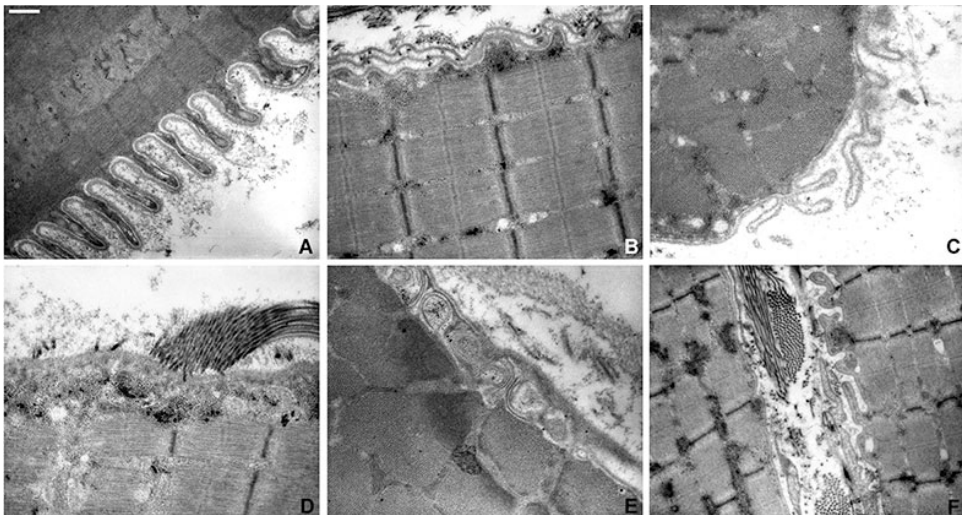
Figure 4. Ultrastructural investigation of muscle biopsies of COL6 ‐ RM. Representative ultrastructural images of skeletal muscle from Col6 ‐ RM patients. Papillary projections coursing perpendicularly ( A ) or horizontally ( F ) to the fiber surface. Basal lamina replication ( B ) or extroflection ( C ). Collagen fibrils closely localized at the basal lamina ( D – F ). Subsarcolemmal vacuoles containing membranous profiles ( E ). Scale bar: ( A – E ) 0.83 μ m, ( F ) 1.43 μ m.